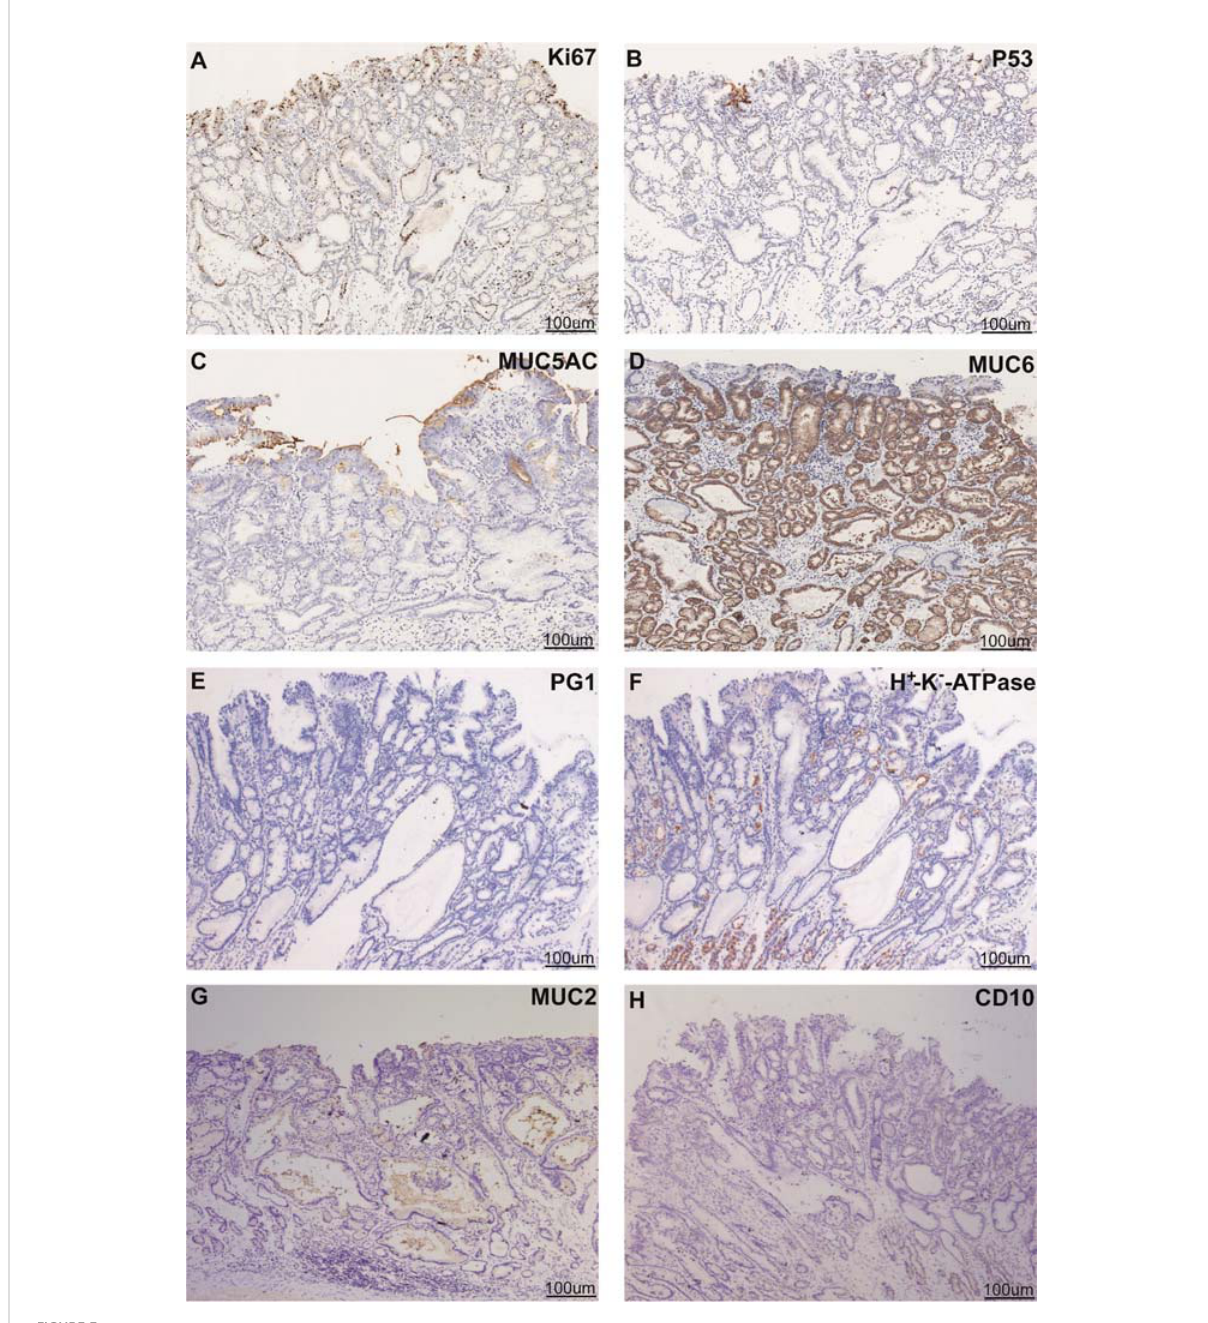
FIGURE 3 Phenotypic marker expression by immunohistochemistry staining with Ki67 (A) , P53 (B) , MUC5AC (C) , MUC6 (D) , PG1 (E) , proton pump (H + -K + - ATPase) (F) , MUC2 (G) , and CD10 (H) . Scale bars represent 100 m m. Black arrows indicate different positively stained